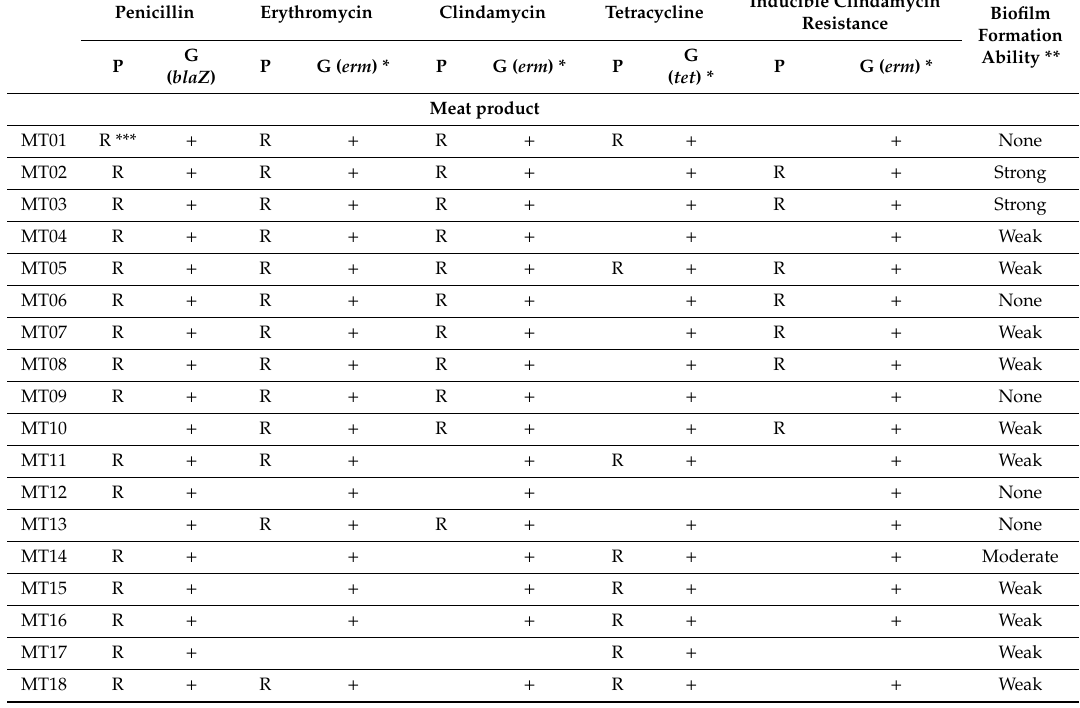
Table 5. Phenotypic resistance (P) and the associated genes (G), as well as the biofilm formation abilities of 54 S. aureus isolates from RTEIB foods, including meat, dairy, fruit and vegetables, and